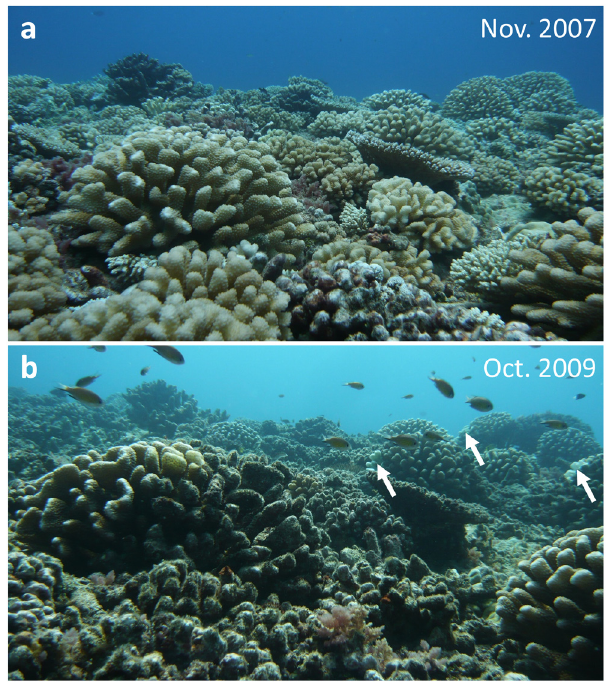
Figure 1. Widespread coral decline and survival of guarded corals that partially or fully resisted seastar predation. Pictures were taken at 6 m depth on Tiahura reef in Moorea, French Polynesia, before ( a ) and after ( b ) this location was invaded by crown-of-thorns seastar (COTS) swarms. Surviving guarded corals typically measured above 60 cm in diameter. Arrows in b indicate white feeding scars characteristic of recent COTS predation on several of the guarded coral colonies ( Pocillopora eydouxi